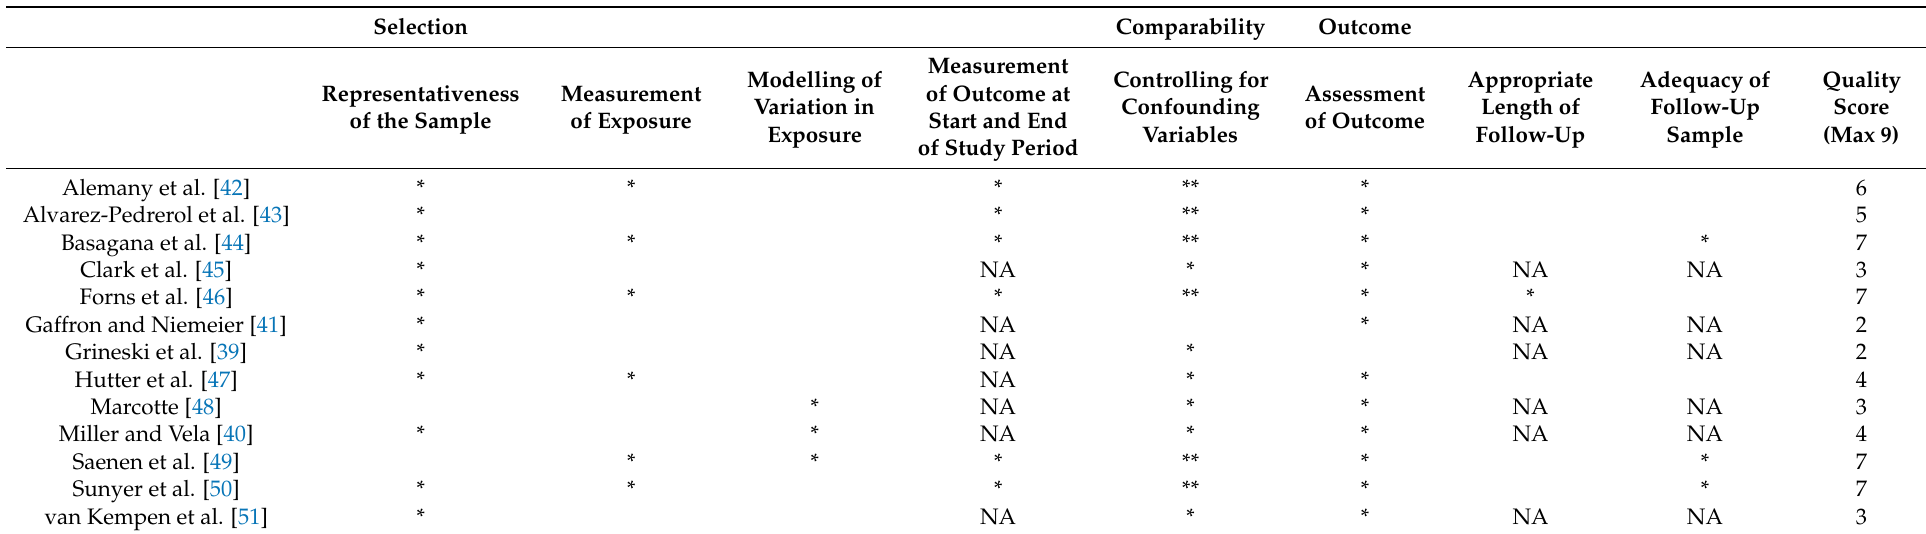
Table 2. Quality assessment of reviewed